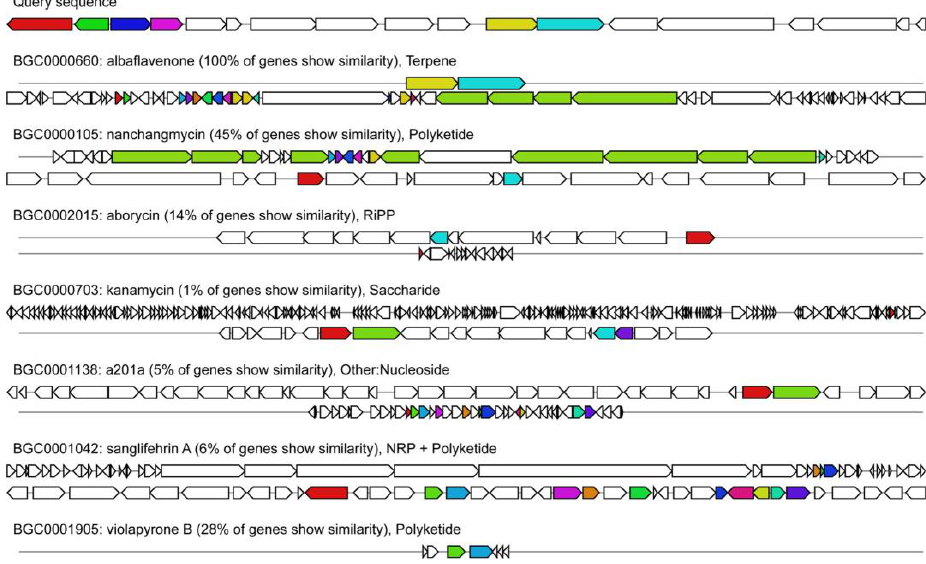
Figure 4. The similar BGC clusters detected for genes encoding compounds with antimicrobial activity predicted using anti-SMASH v. 6.0.1. activity predicted using anti-SMASH v.